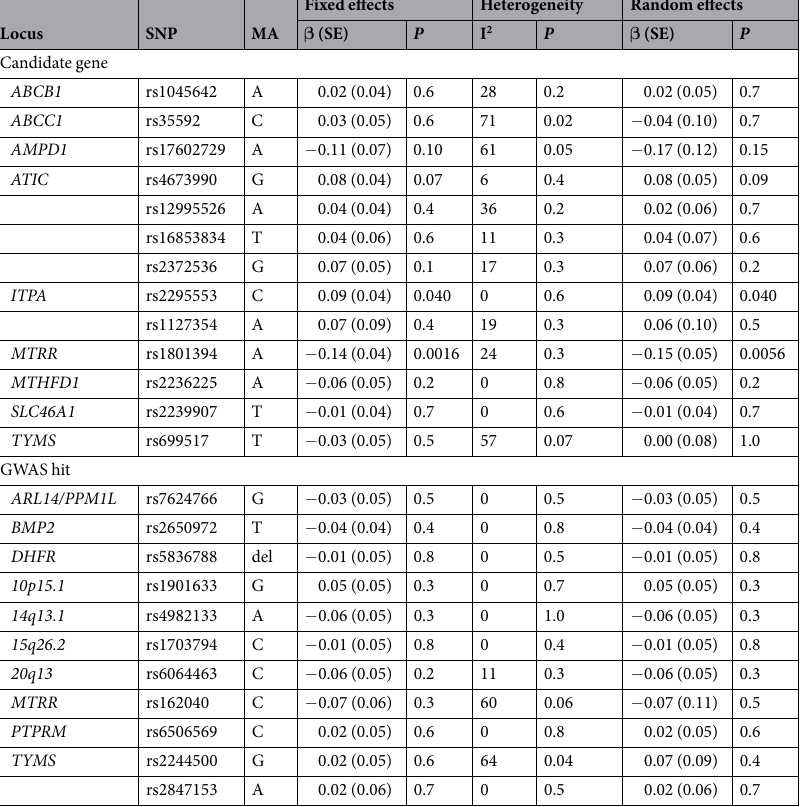
Table 2. Metaanalysis of the association of the 24 SNPs with response to MTX assessed as Δ DAS28 at 6 months in the four populations of RA patients. Summary regression coefficients ( β ) and their standard errors (SE) obtained with fixed effects and random effects metaanalysis are presented together with the inconsistency (I 2 )